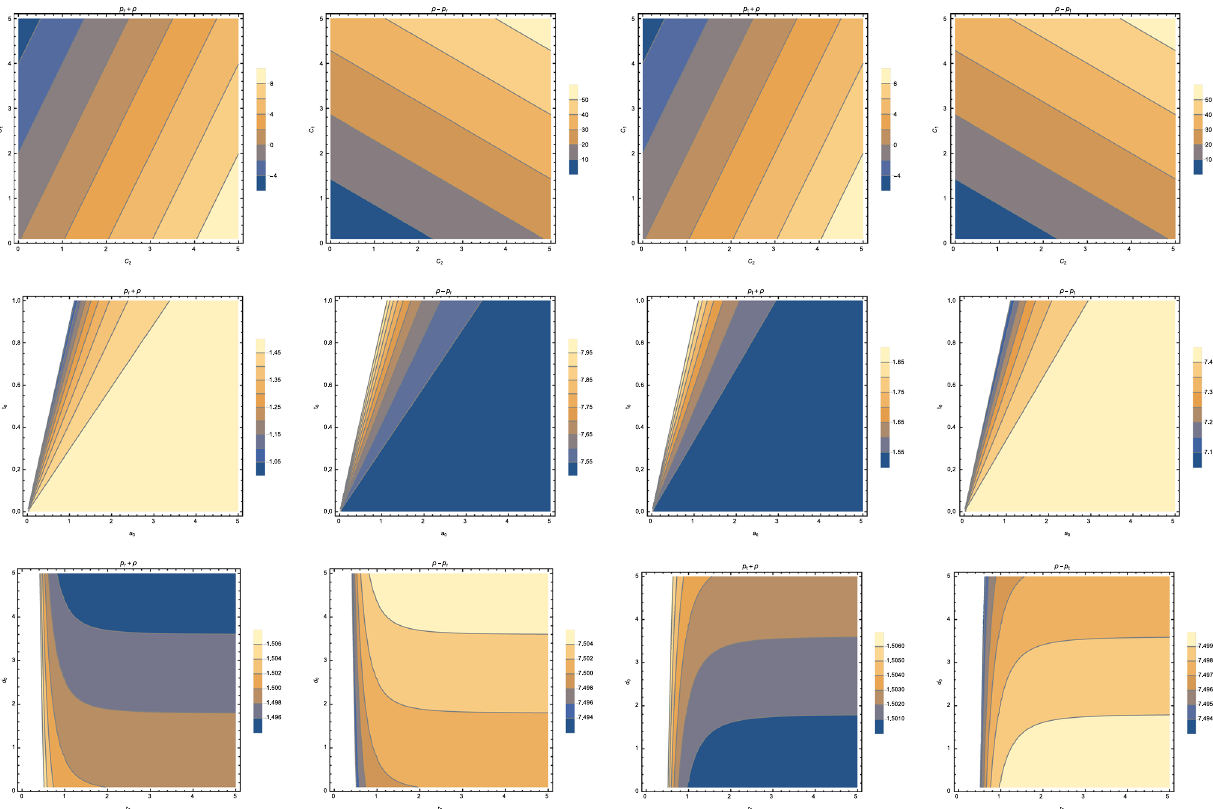
Fig. 2 The above panels shows the variations in ρ ± p r and ρ ± p t w.r.t changing parameters corresponding to Eq. (20). Here C 1 , C 2 is taken with agreement to the constraints set by f ( R ) viability conditions